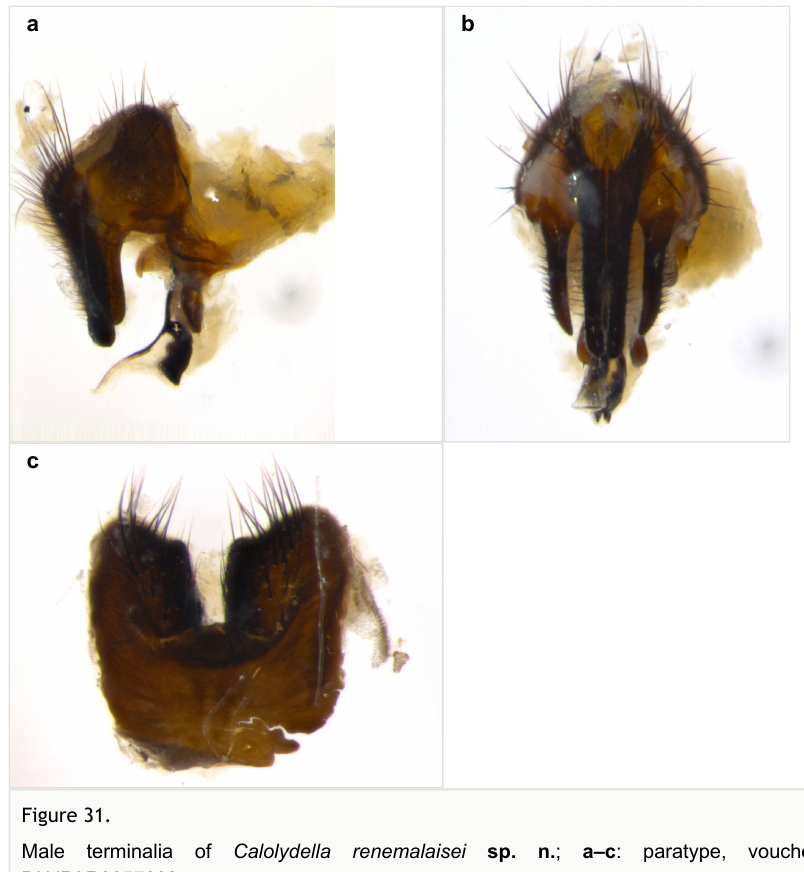
Male terminalia of Calolydella renemalaisei sp. n. ; a–c : paratype, voucher n.